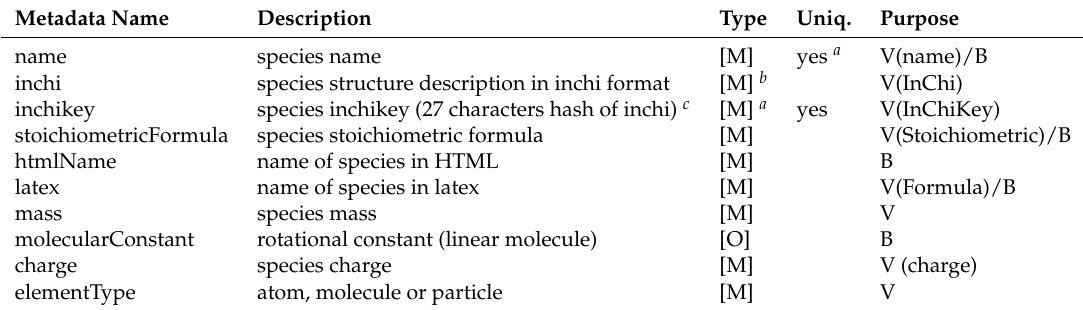
Table 1. List of properties/metadata for the object “Element”. The symbols [M] and [O] indicate that the metadata are either mandatory or optional in the import file. In the column “Uniq.”, we indicate whether the metadata defines the uniqueness of the object. In the column “Purpose”, we indicate whether the information is meant for the BASECOL (B) public WebUI display and/or for VAMDC (V) interoperability. In “V(parameter)”, “parameter” indicates the name of column in the species database. The mass unit is atomic mass unit (a.m.u) and the default value for mass is